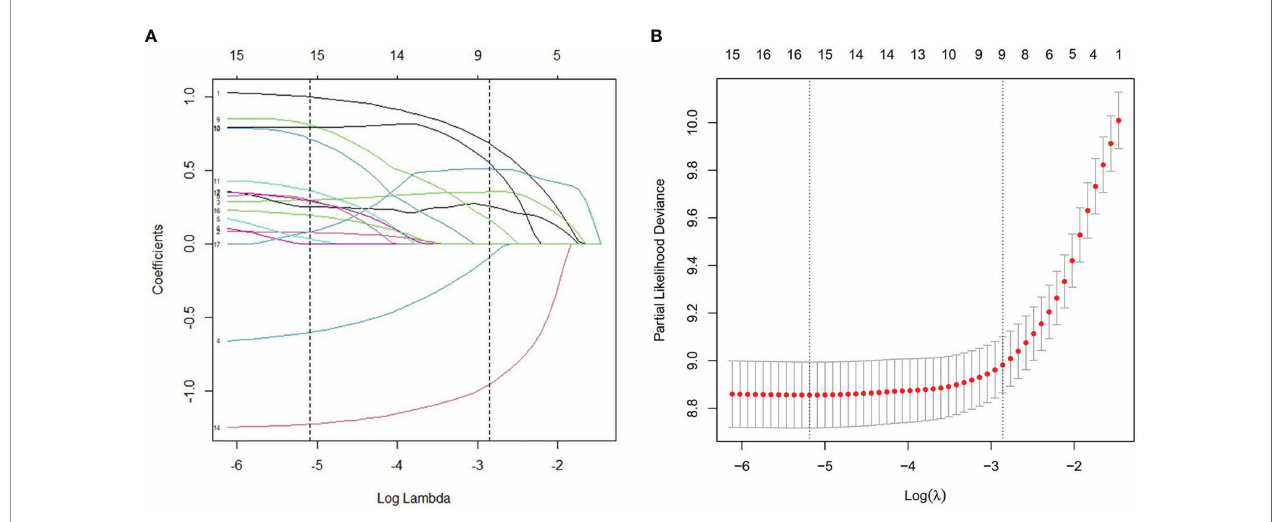
FIGURE 3 | L1-penalized (Lasso) regression model were adopted to determine further predictive variables in test dataset. (A) LASSO coef fi cient patterns of the features. (B) Ten-time cross-veri fi cation for tuning parameter selection in the Lasso model.